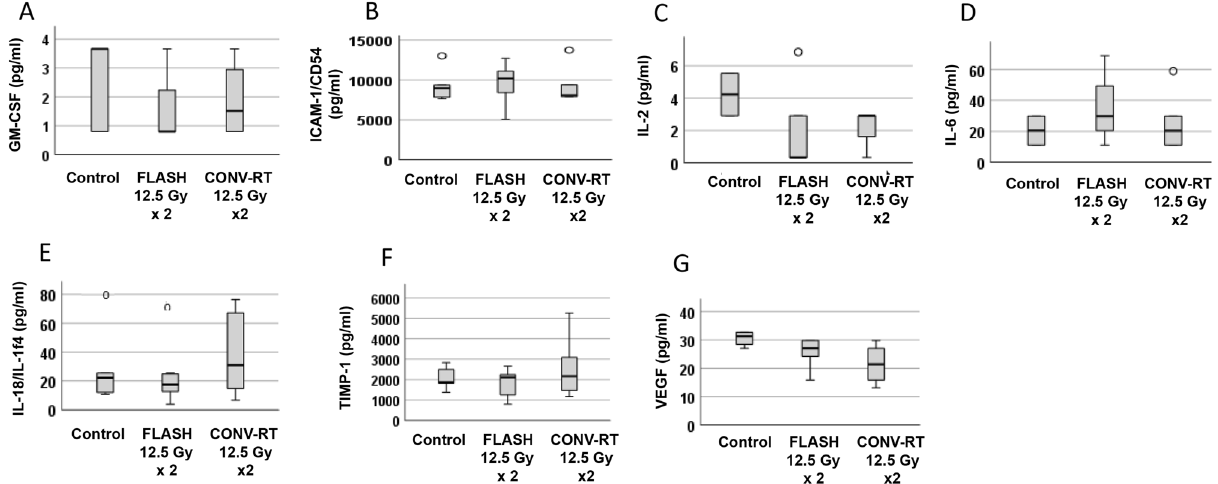
Figure 7. Serum levels in animals with intracranial tumors treated with FLASH, CONV-RT or control animals. Serum was collected upon euthanasia and compared between animals that had received FALSH-RT, CONV-RT or were control animals. Missing data was due to values below those that could be technically detected. TNF- alpha was out of range below the reference interval in all animals except one, and thus could not be analyzed further. * indicates significant differences compared to the control group. o indicates an outlier. ( A ) GM-CSF in n = 5 control versus n = 4 FLASH 12.5 Gy × 2 and n = 4 CONV-RT 12.5 Gy × 2 treated animals. GM-CSF in healthy animal was out of range below detectable levels. No significant difference was observed. ( B ) ICAM-1/ CD54 in n = 5 control versus n = 6 FLASH 12.5 Gy × 2 and n = 5 CONV-RT 12.5 Gy × 2 treated animals. GM-CSF in healthy animal was out of range below detectable levels. No significant difference was observed. ( C ) IL-2 in n = 2 control versus n = 5 FLASH 12.5 Gy × 2 and n = 3 CONV-RT 12.5 Gy × 2 treated animals. IL-2 in healthy animal = 2.91 pg/ml. No significant difference was observed. ( D ) IL-6 in n = 2 control versus n = 3 FLASH 12.5 Gy × 2 and n = 5 CONV-RT 12.5 Gy × 2 treated animals. IL-6 in healthy animal = 29.77 pg/ ml. No significant difference was observed. ( E ) IL-18 in n = 6 control versus n = 7 FLASH 12.5 Gy × 2 and n = 5 CONV-RT 12.5 Gy × 2 treated animals. IL-18 in healthy animal = 107.14 pg/ml. No significant difference was observed. ( F ) TIMP-1 in n = 6 control versus n = 7 FLASH 12.5 Gy × 2 and n = 5 CONV-RT 12.5 Gy × 2